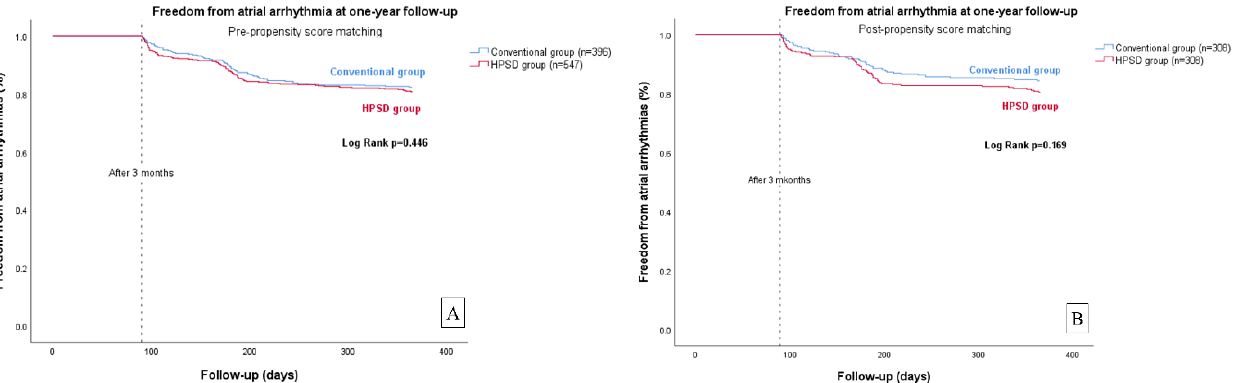
Figure 2. Kaplan–Meier survival analysis of freedom from arrhythmia at one-year follow-up. ( A ) Freedom from arrhythmia at one-year follow-up before propensity-score matching; ( B ) Freedom from arrhythmia at one-year follow-up after propensity-score matching.